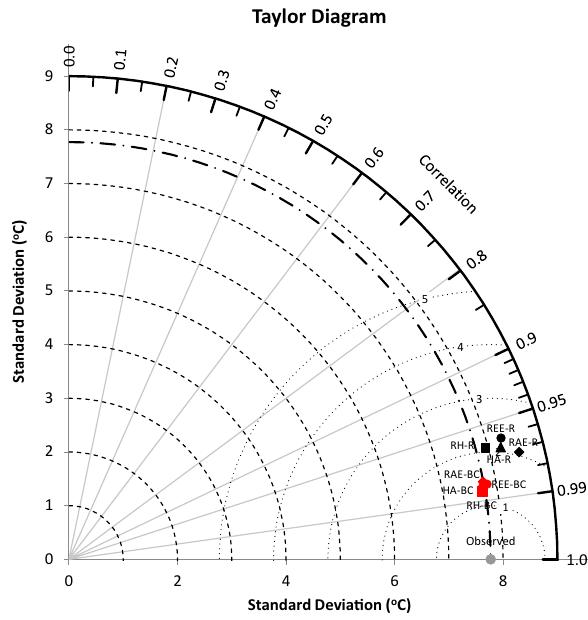
Fig. 7 Taylor diagram of raw (R) and bias-corrected (BC) RCM